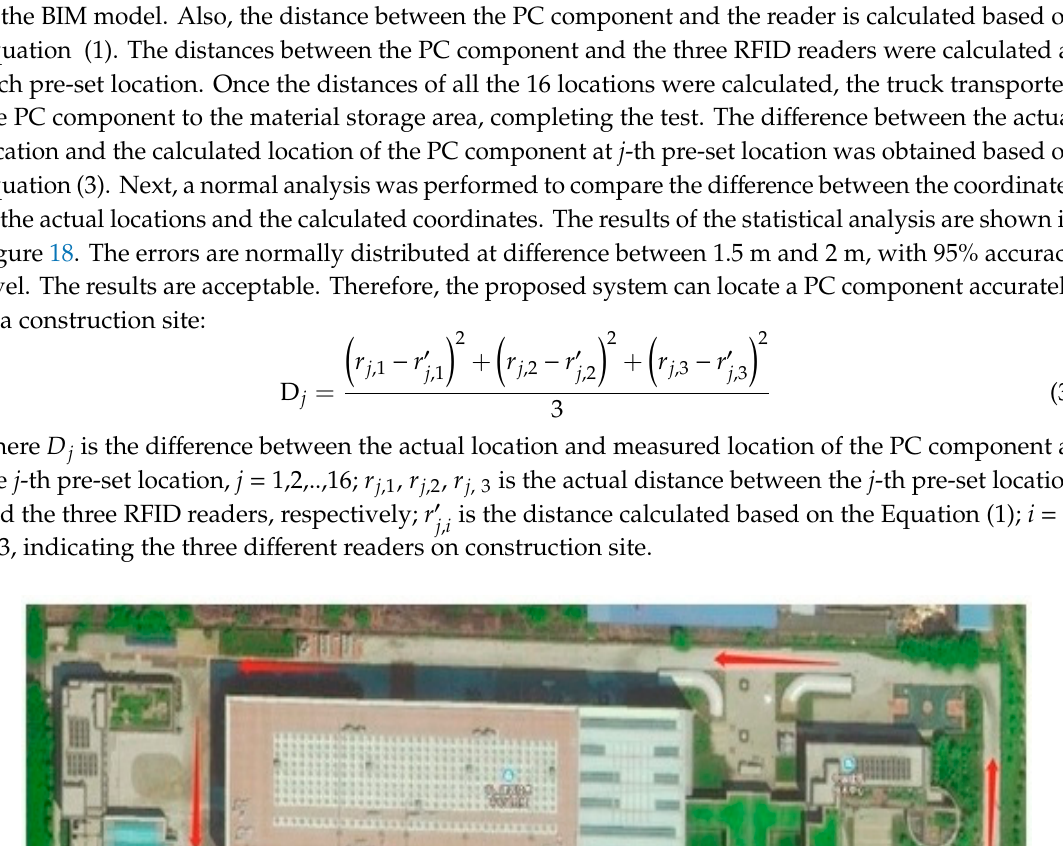
Table 3. The properties of the active RFID tag.